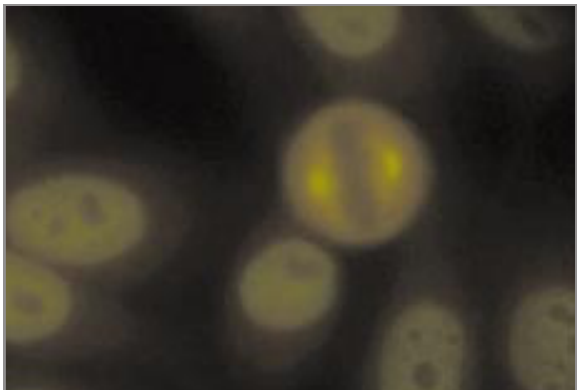
Figura 23 – Fuso mitótico NuMA 1